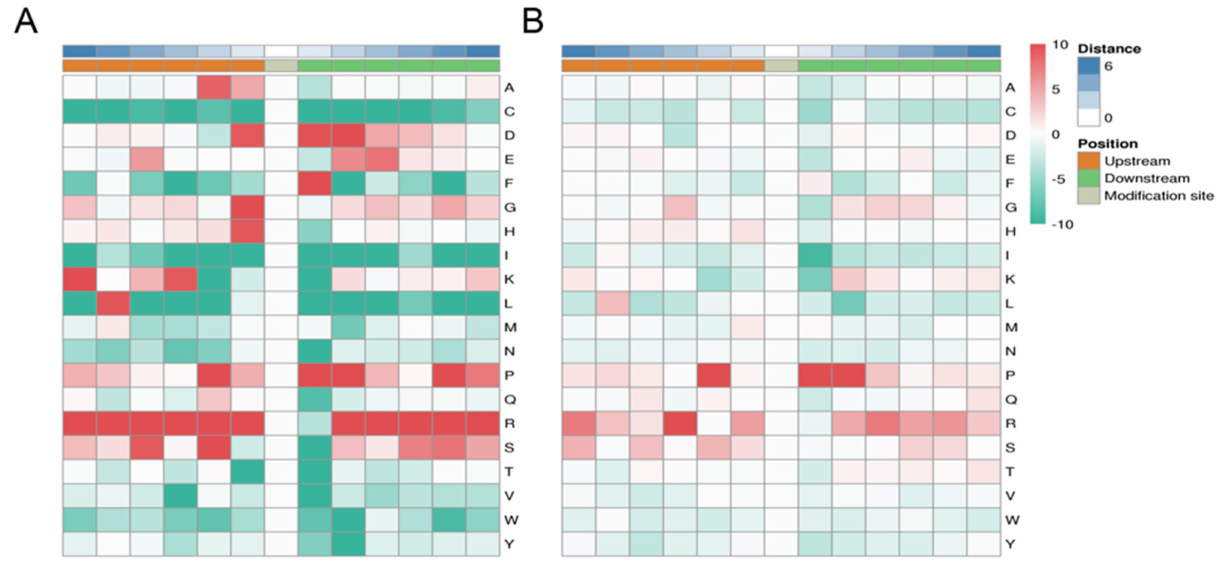
Figure 3. Analysis of phosphorylation sites. The motif enrichment heatmap of upstream and downstream amino acids of all identified S ( A ) and T ( B ) modification sites. Red indicates that the amino acid was significantly enriched near the modification site, and green indicates that the amino acid was significantly reduced near the modification